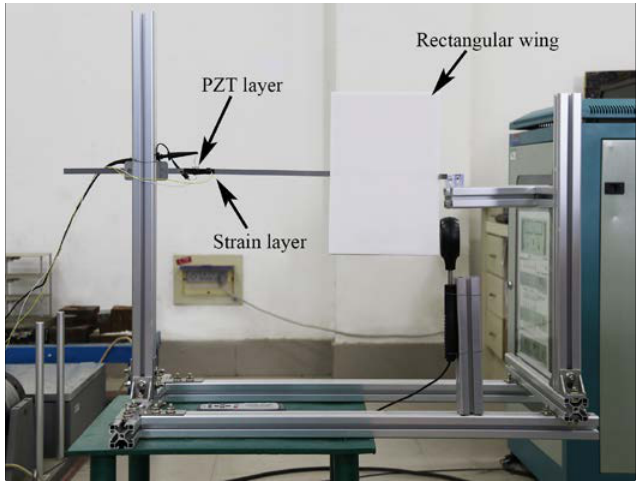
Figure 4. Experimental setup of the DFEH.